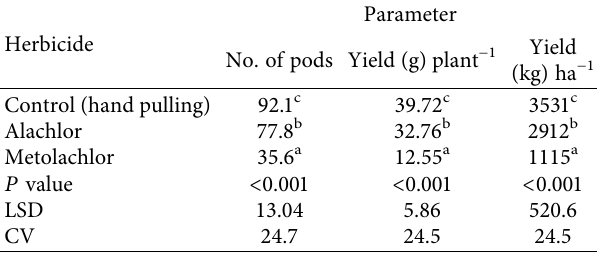
Table 4: Response of different sesame varieties to commonly used selective preemergence herbicides.